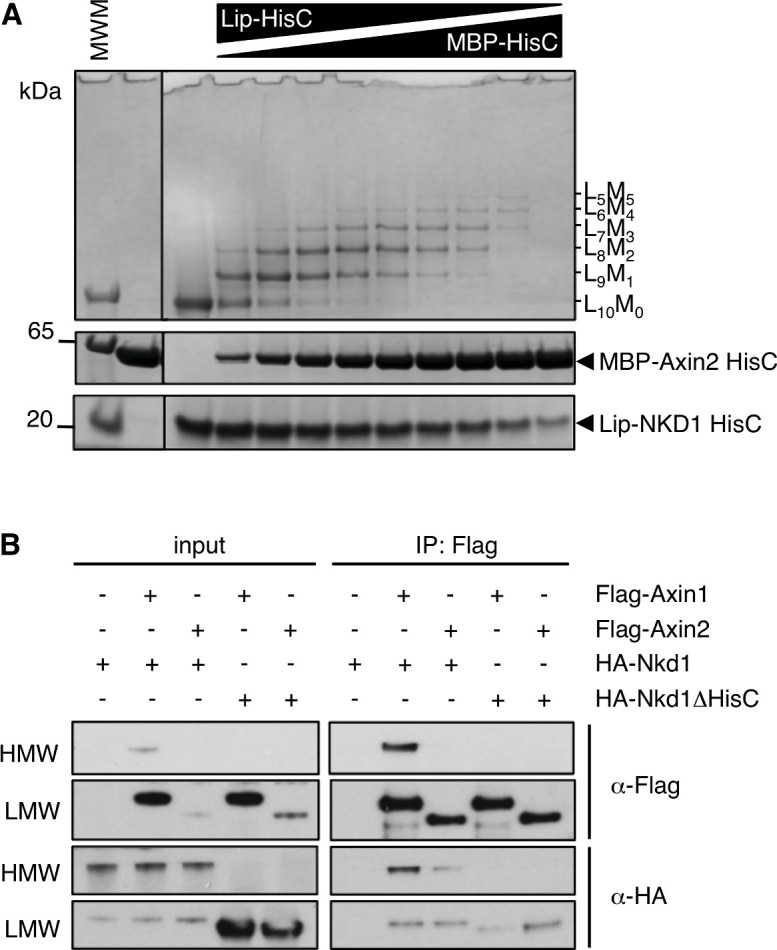
Co-aggregation between NKD1 and Axin2.(A) Co-aggregation assays after mixing purified recombinant Lip-NKD1-HisC and MBP-Axin2-HisC (KHVHHHYIHHHA) at different ratios. (B) CoIP assays between proteins co-expressed in transfected HEK293T cells, as indicated above panels, revealing formation of HMW co-aggregates between HA-Nkd1 and Flag-Axin1 but not Flag-Axin2.